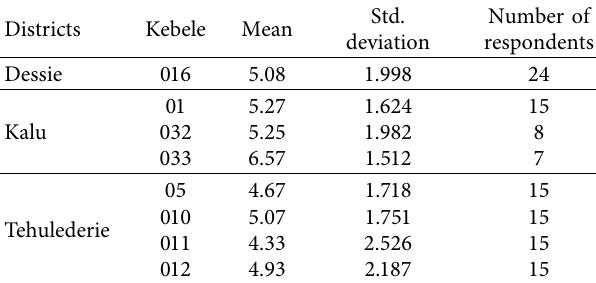
Table 2: Average family size of respondents in Dessie, Kalu, and Tehulederie